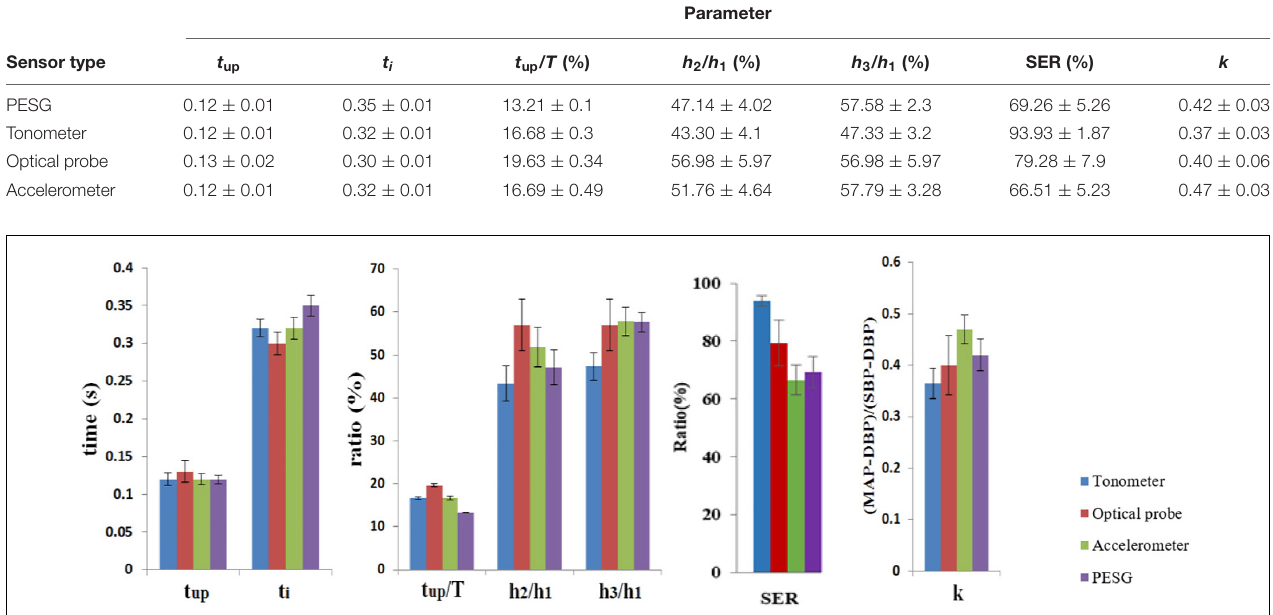
FIGURE 6 | Comparison of the mean ± SD of the parameters obtained by all four sensors for all